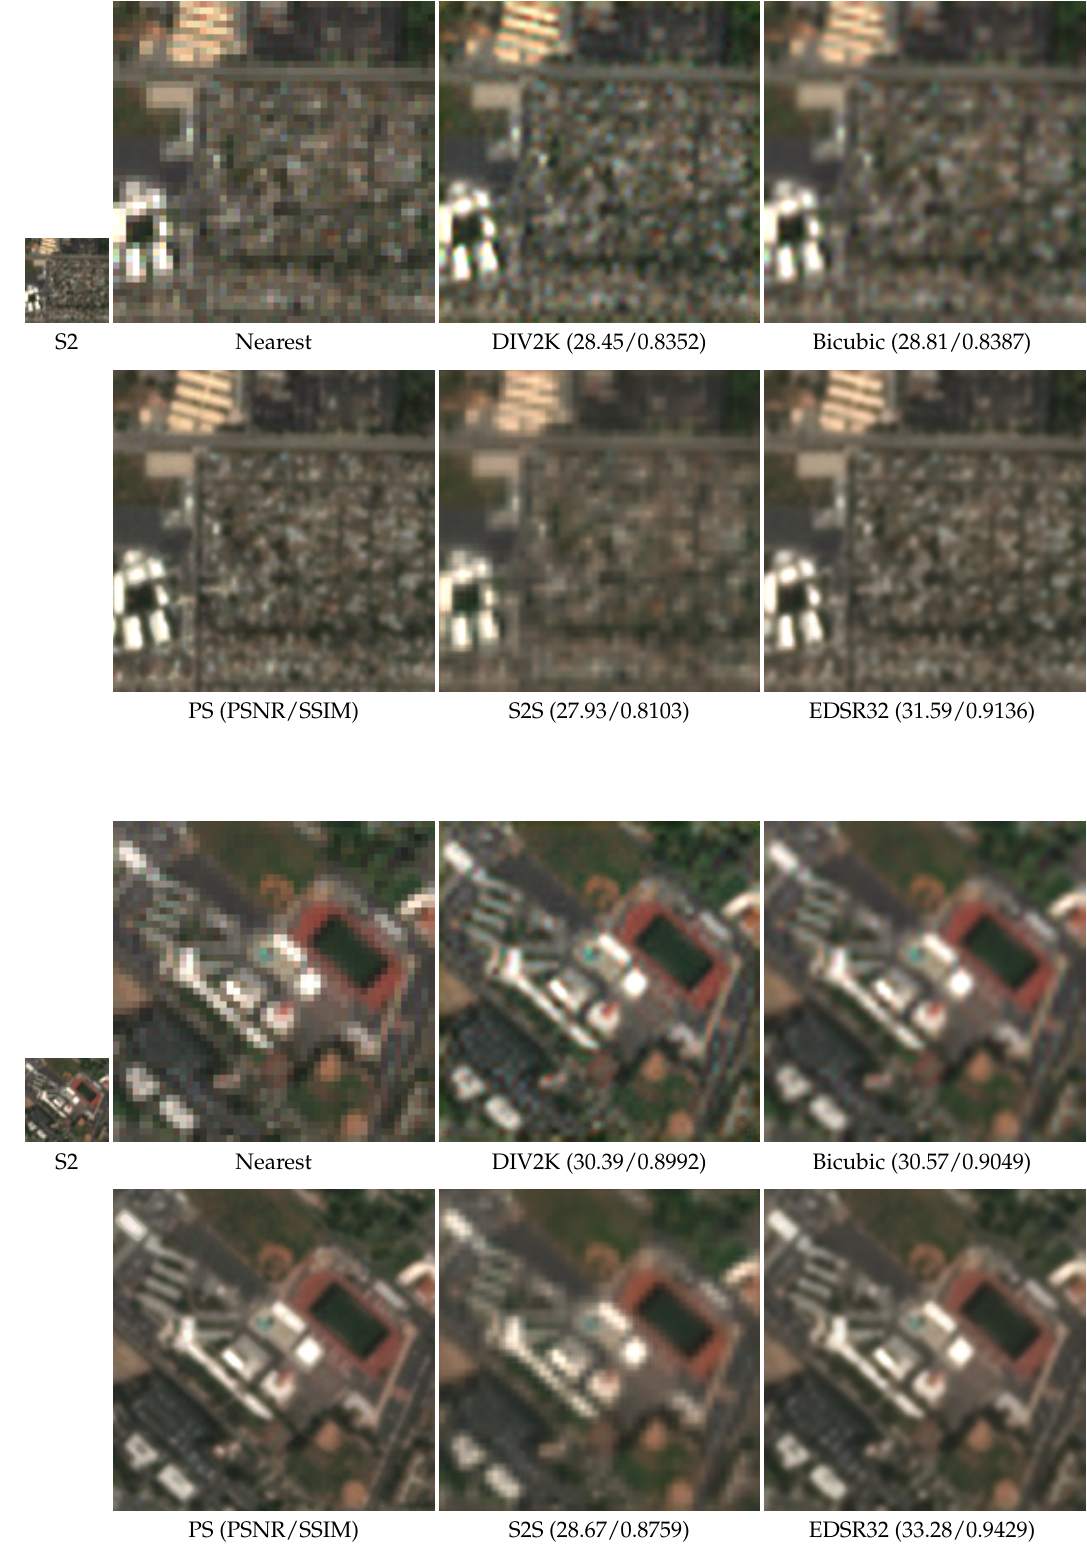
Figure A3. Visual comparison (RGB) of the baseline and EDSR32 models (tiles from test